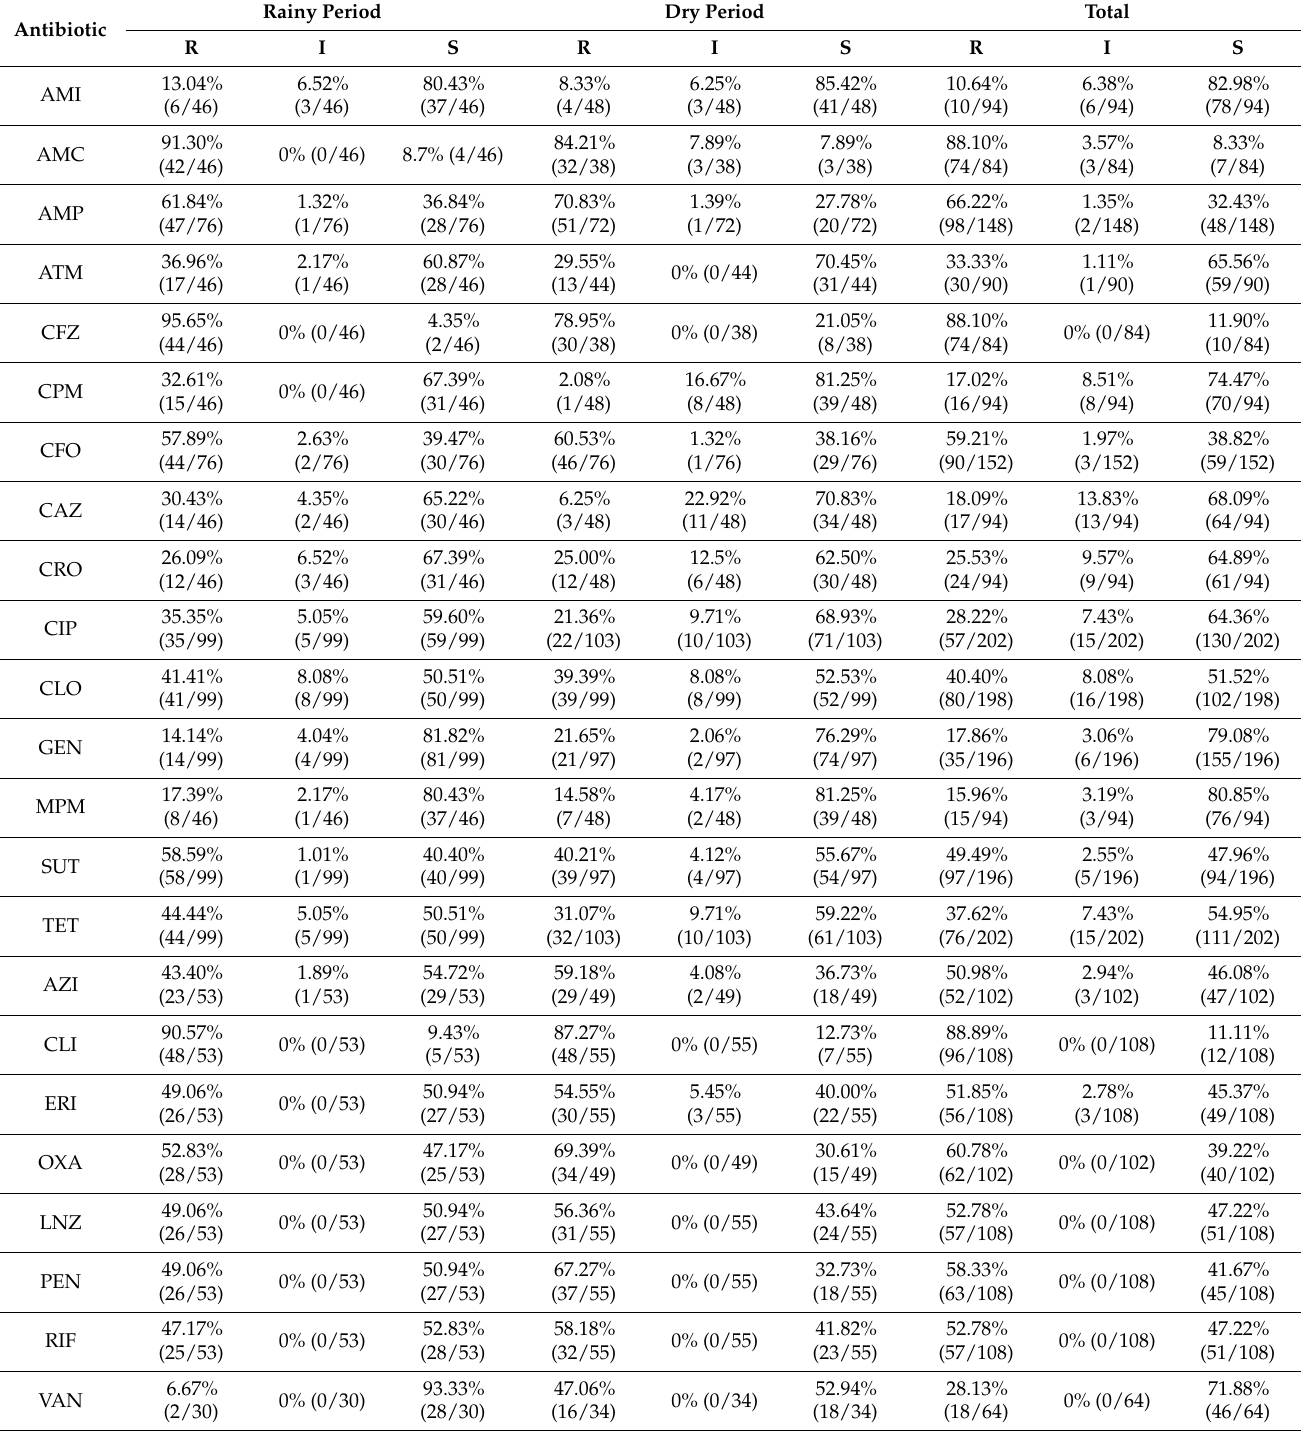
Table 3. Percentage of sensitivity and total resistance of bacterial isolates bioprospected from Meia Ponte